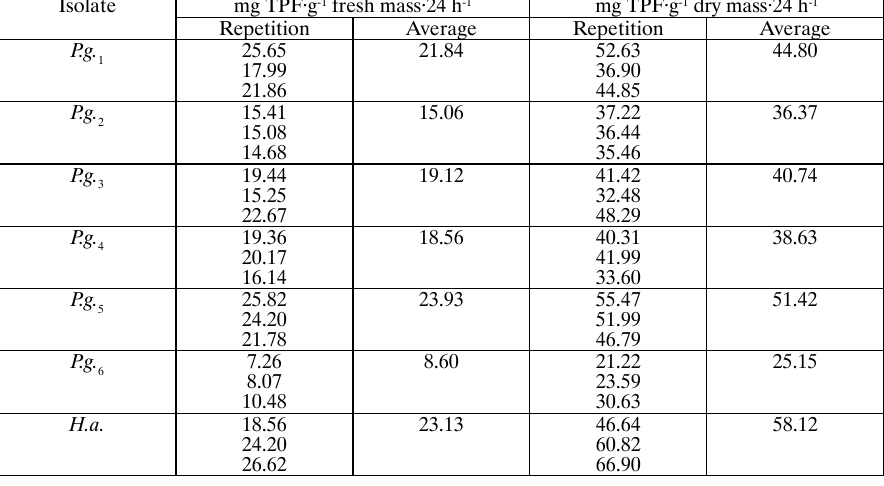
Dehydrogenase activity of P. gigantea isolates and H. annosum isolates